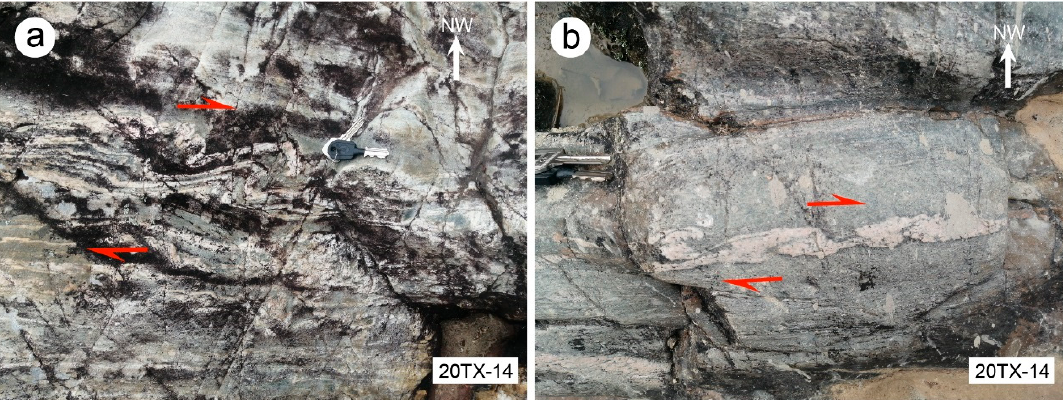
Figure 7. Asymmetric intrafolial folds ( a ) and boudins ( b ) in the SE domain of the Taoxi dome indicate a dextral sense of shear. The red arrows show the shear sense.